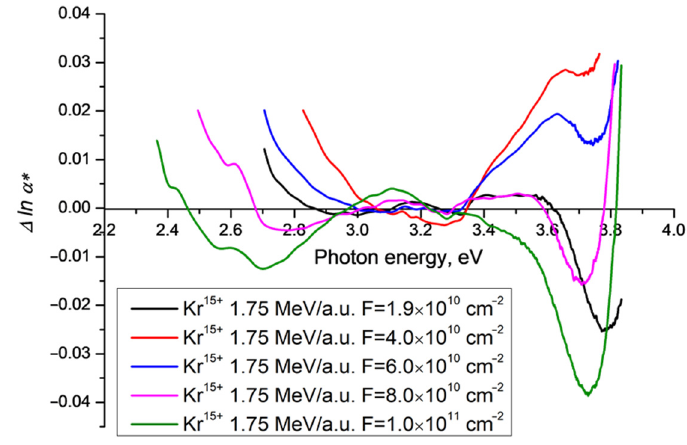
Figure 3. Difference functions ∆ ln α * ( ν ) for PET film samples irradiated on a cylindrical aluminum drum with Kr 15+ ions of energy 1.75 MeV/a.u. and fluences ranging from 4 × 10 10 cm − 2 to 1 × 10 11 cm − 2 in normal geometry. The black line shows the same sample as in Figure 2.